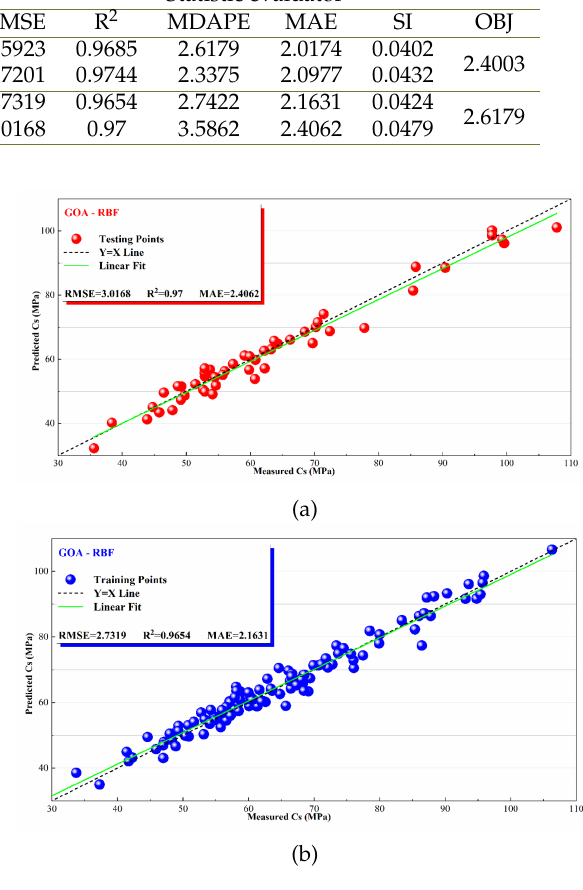
Fig. 5. The correlation plot of measured and predicted values of compressive strength with the RBF-MPA model